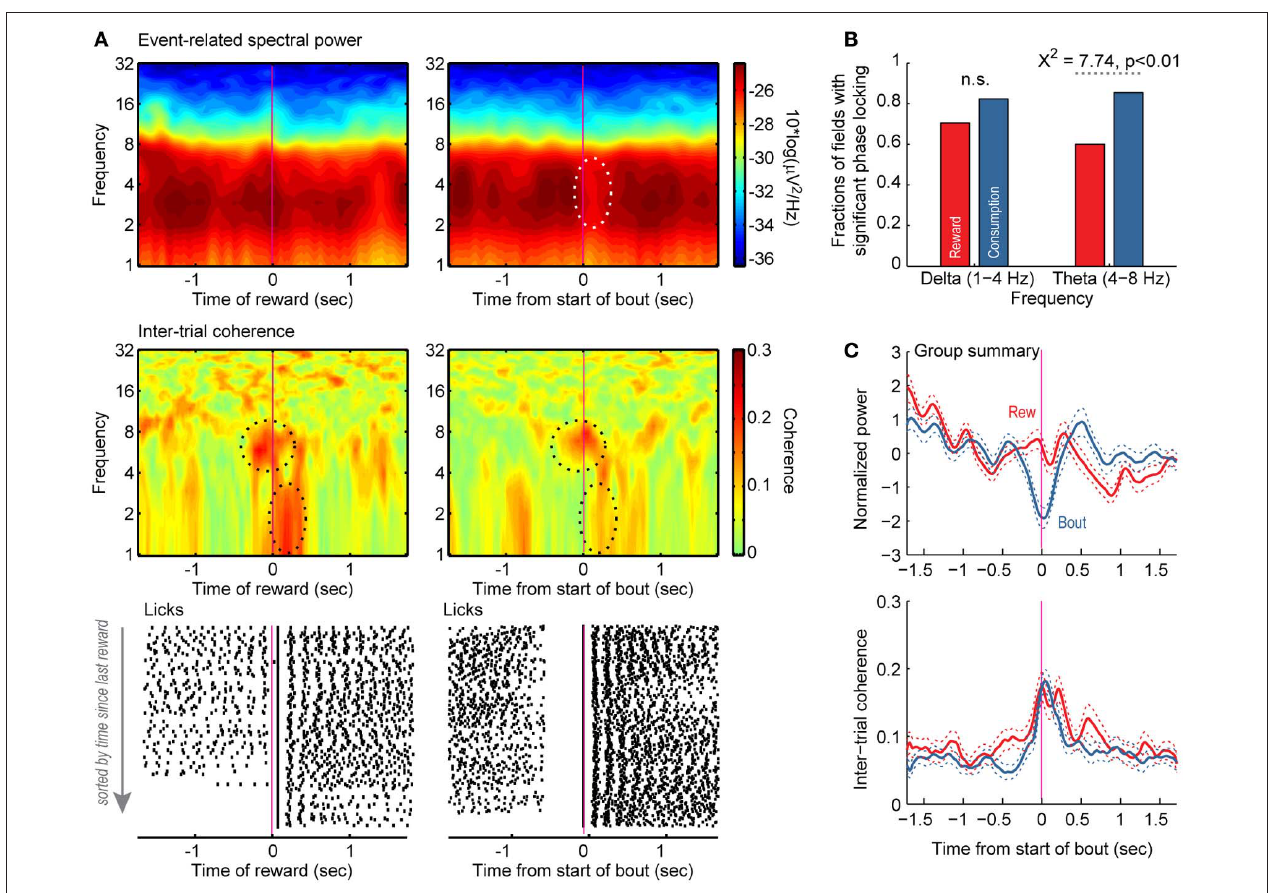
highlighted with black dashed lines, one between 4 and 8Hz (theta) and the other between 1 and 3Hz (delta). Significant phase locking in the range of theta occurred both when rats licked at the start of the reward period and when rats emitted bouts of licks at other times in the session. Significant delta phase locking was only detected when reward was delivered. (B,C) Group summaries for the fractions of fields with significant phase locking in the ranges of delta and theta and average event-related power and inter-trial coherence around the delivery of reward (red) and the onset of licking